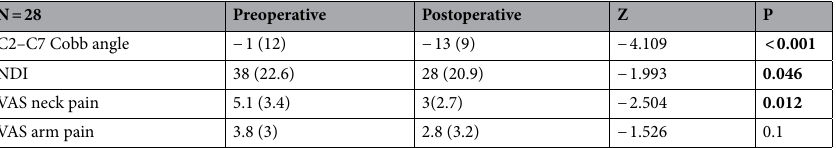
Table 3. Outcomes of all patients operated with four-level ACDF. Descriptive data is presented as mean (SD or range). Bold values indicate statistical significance (P < 0.05). ACDF anterior cervical discectomy and fusion, NDI neck disability index, VAS visual analogue